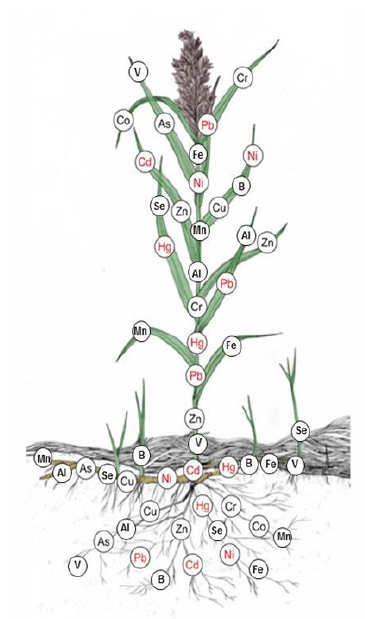
Figure 3. Arrangement of heavy metals in various parts of P. australis , own study.